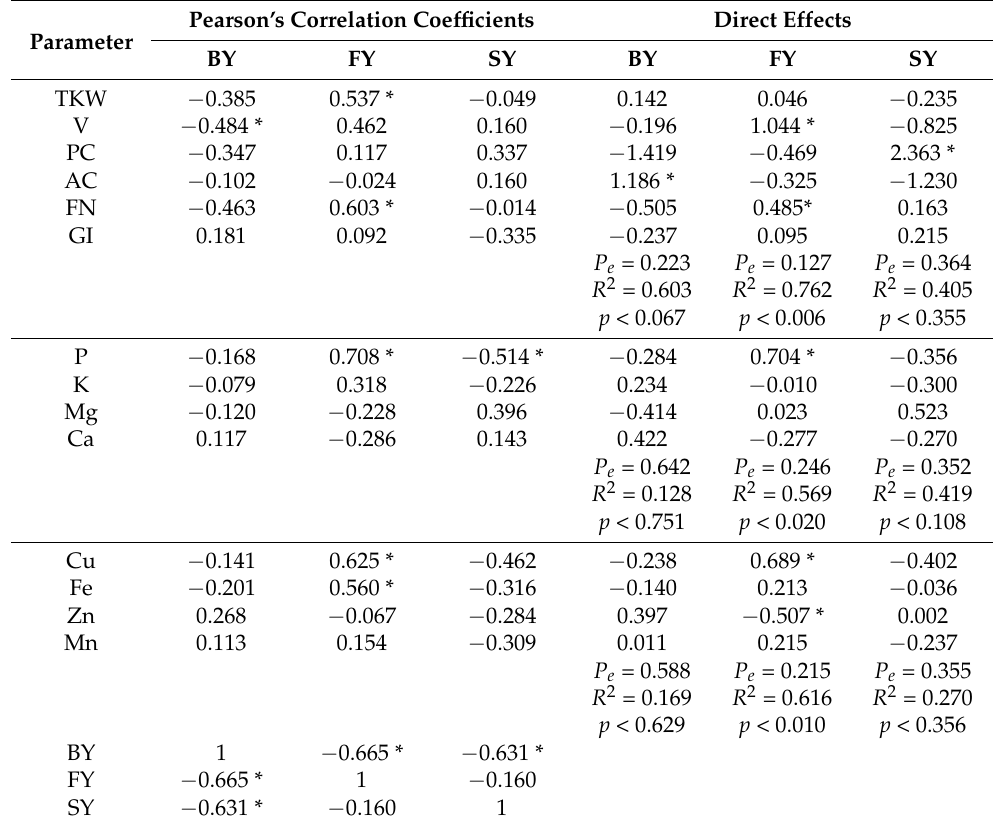
Table 4. Correlation matrix of grain quality parameters, macronutrients, micronutrients, and milling yield components ( n =